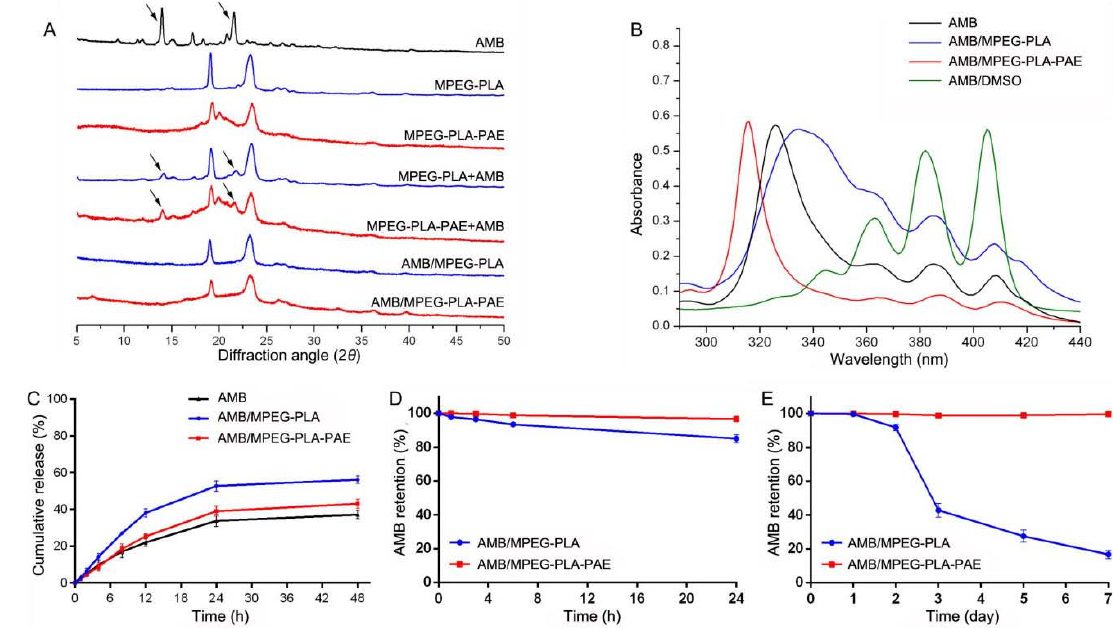
Figure 4. ( A ) XRD analysis of AMB, MPEG-PLA, MPEG-PLA-PAE, MPEG-PLA + AMB mixture, MPEG-PLA-PAE + AMB mixture, AMB/MPEG-PLA micelles, and AMB/MPEG-PLA-PAE complex. ( B ) Absorption spectra of AMB in injection solution, micelles, complex, and DMSO solution. ( C )